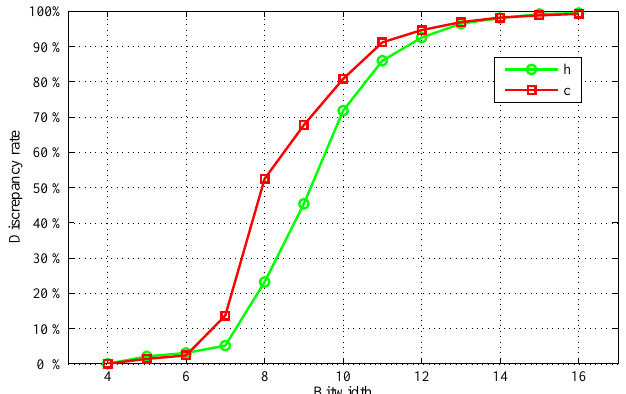
Figure 9. The discrepancy rate vs. the bit-width, to characterize mismatch between the PLAed activation function and its quantized